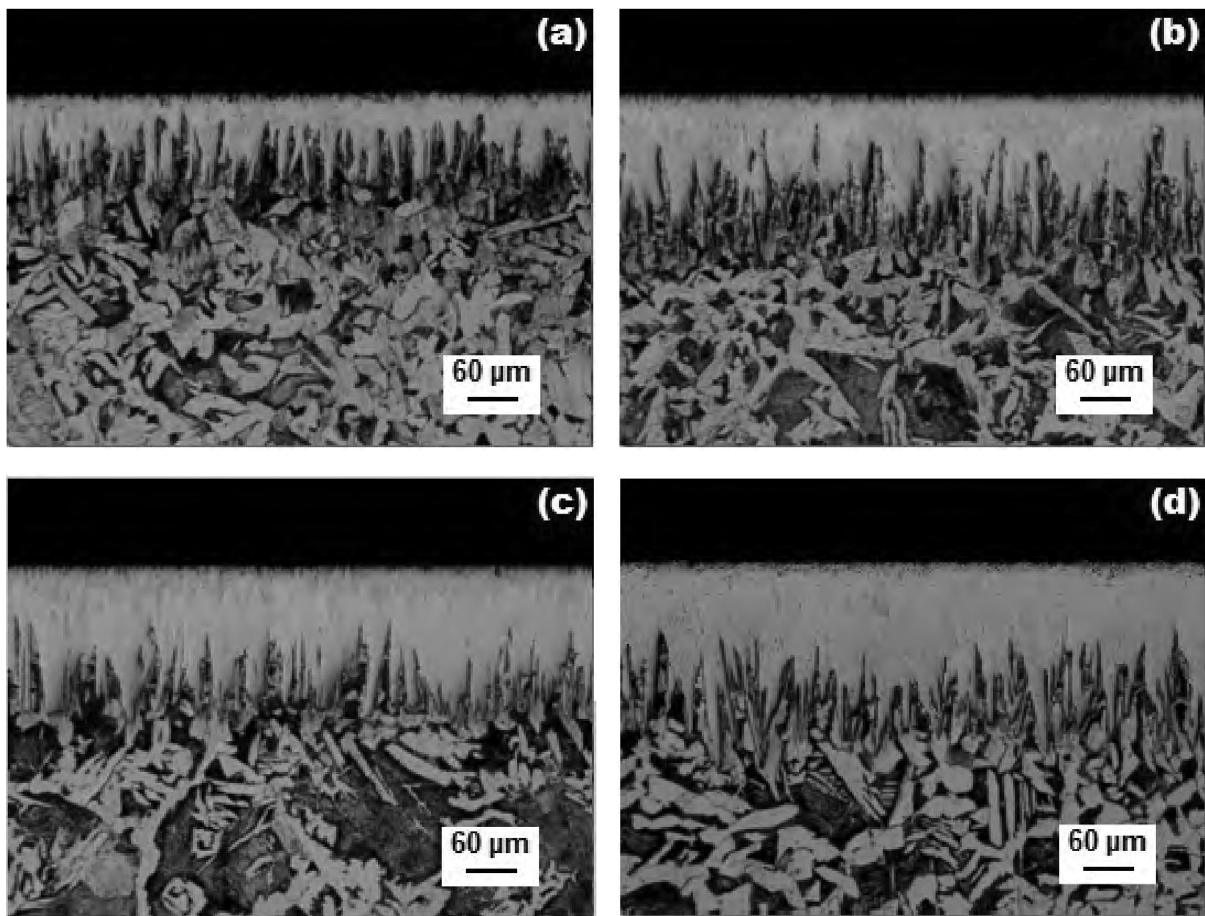
Fig. 3: Optical micrographs of the cross-sections of borided AISI 1026 steel at 1223 K during a variable treatment time: (a) 2 h, (b) 4 h, (c) 6 h and (d) 8 h.